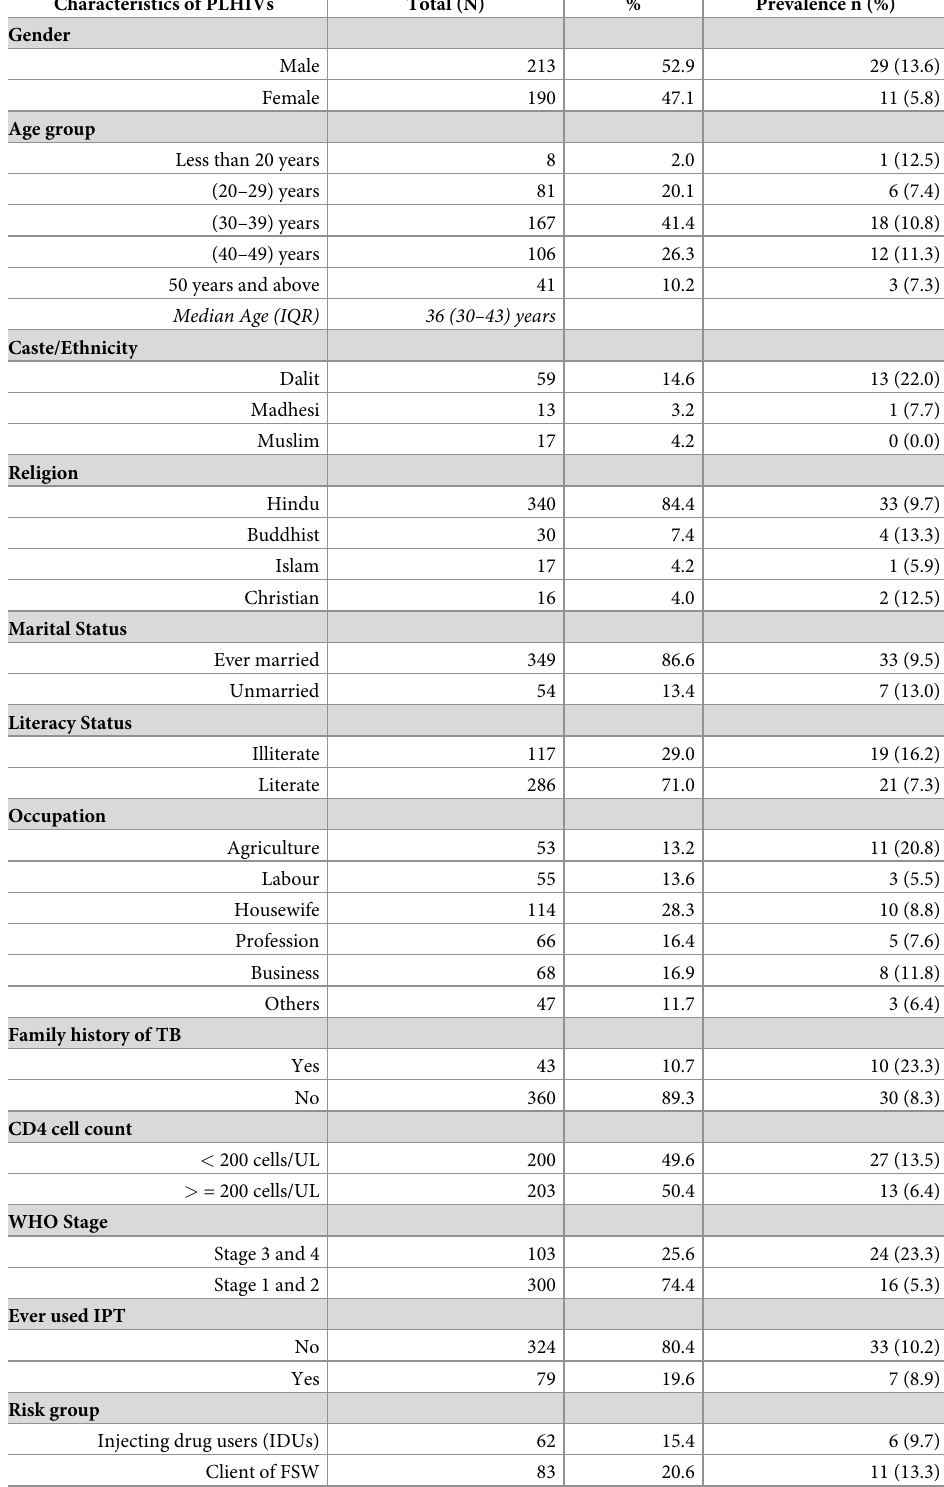
Table 1. Prevalence of TB by socio demographic and clinical characteristics of PLHIVs (N =